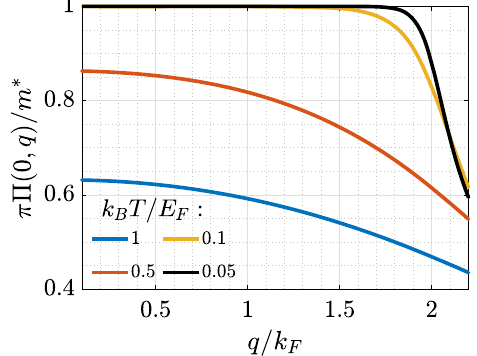
FIG. 7. Normalized polarization function with respect to momentum q , for different temperatures.